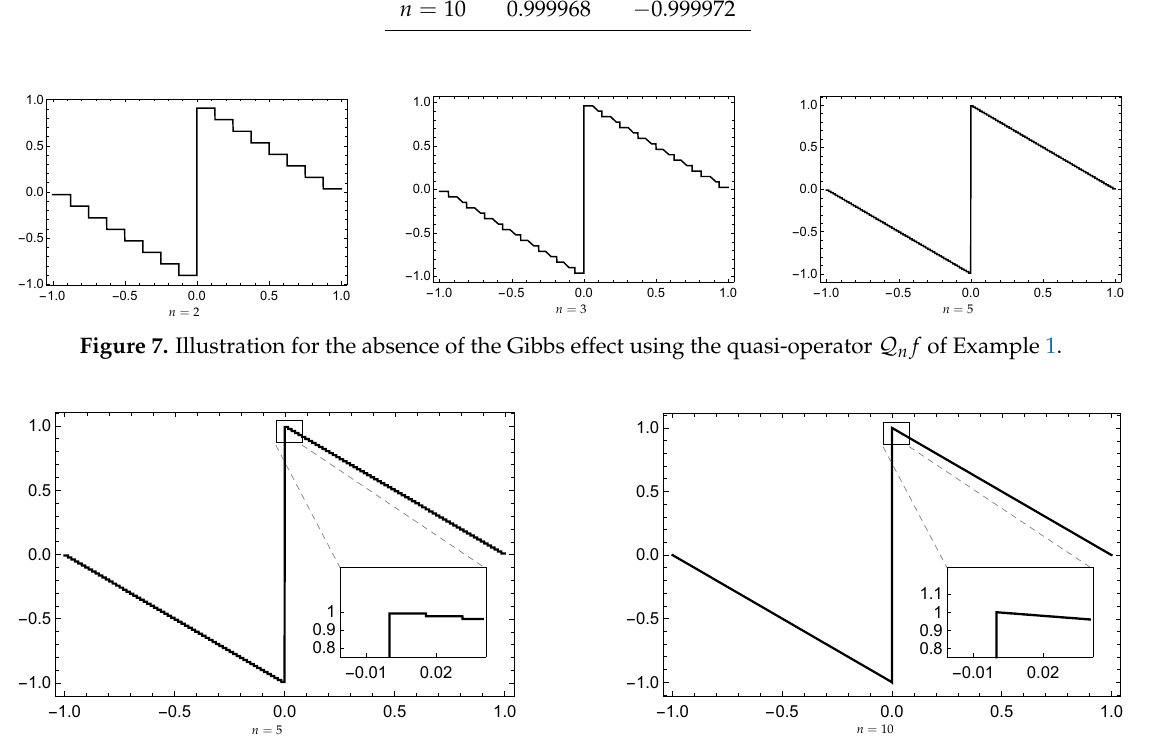
Figure 8. Illustration for the absence of the Gibbs effect using the quasi-operator Q n f of Example 1 for n = 5,10, respectively.